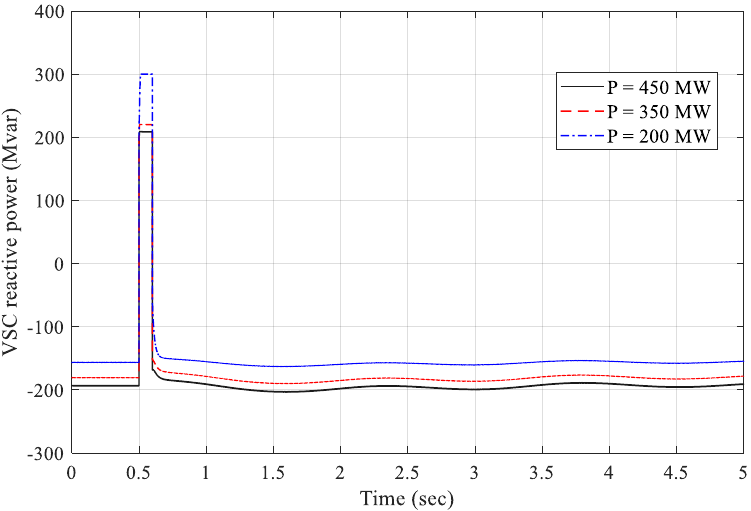
Figure 6. CRPS reactive power output by the different active power outputs of the VSC.